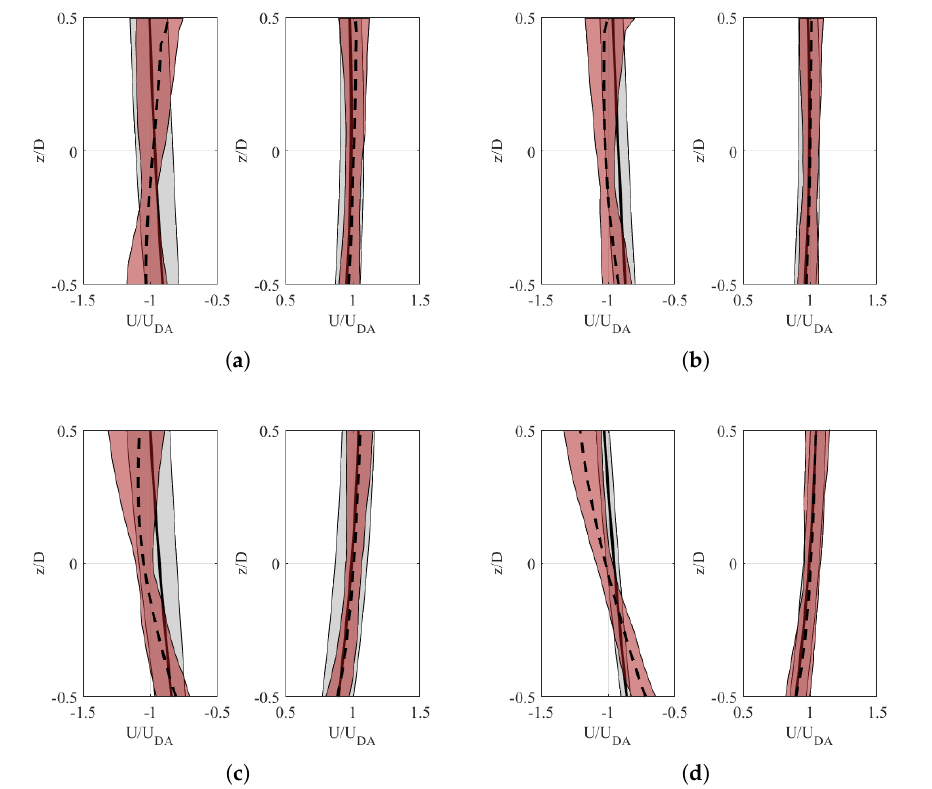
Figure 4. Range of shear profiles for one flow speed case, at two different location and two hub heights, near surface with an origin at z hub = − 15 m and near bed with an origin at z hub = − 28 m, for varying measured profiles (red band), varying predicted profiles (grey band), mean measured (dashed black) and mean predicted (solid black). ( a ) Near Surface, Location A. ( b ) Near Surface, Location B. ( c ) Near Bed, Location A. ( d ) Near Bed, Location